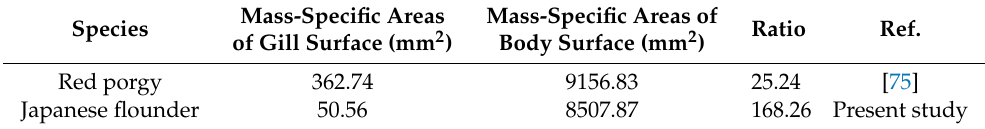
Table 4. Comparing the ratios of mass-specific areas of the gill surface to those of the body sur- face in bilaterally symmetric and asymmetric fish during the early development stages (0.002 g in body